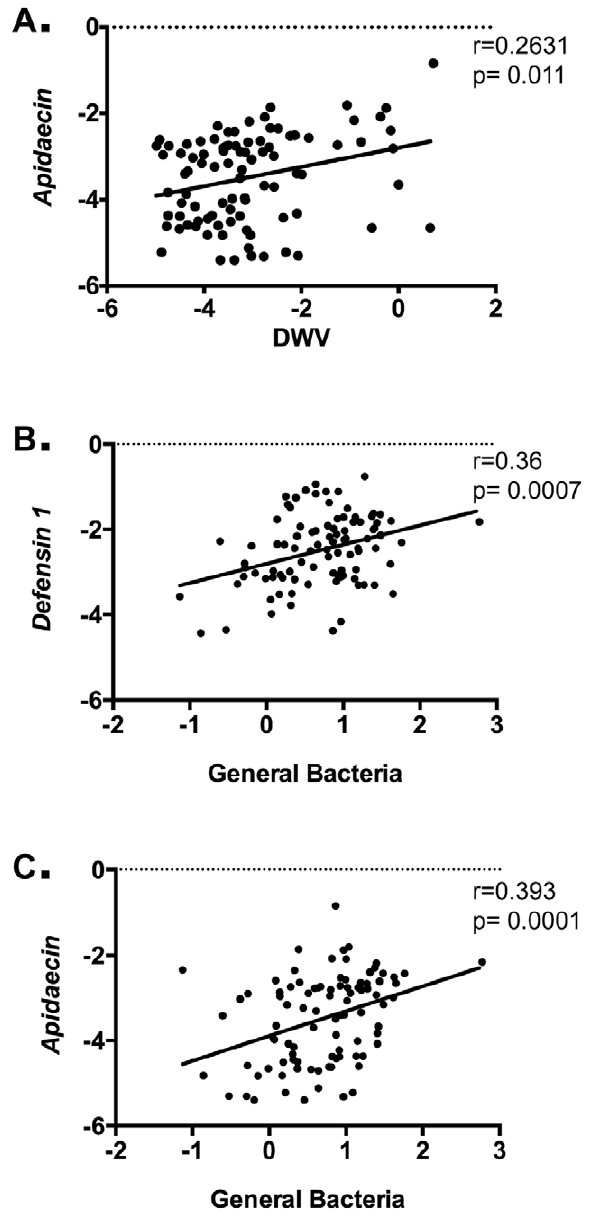
Figure 6. Differences in AMP expression based on level s of DWV and of all bacteria are similar in nurse and foragers. Correlation of levels of Apidaecin (n=92), with levels of DWV (A) and Defensin 1 (B) and Apidaecin (C), with levels of all bacteria (16S